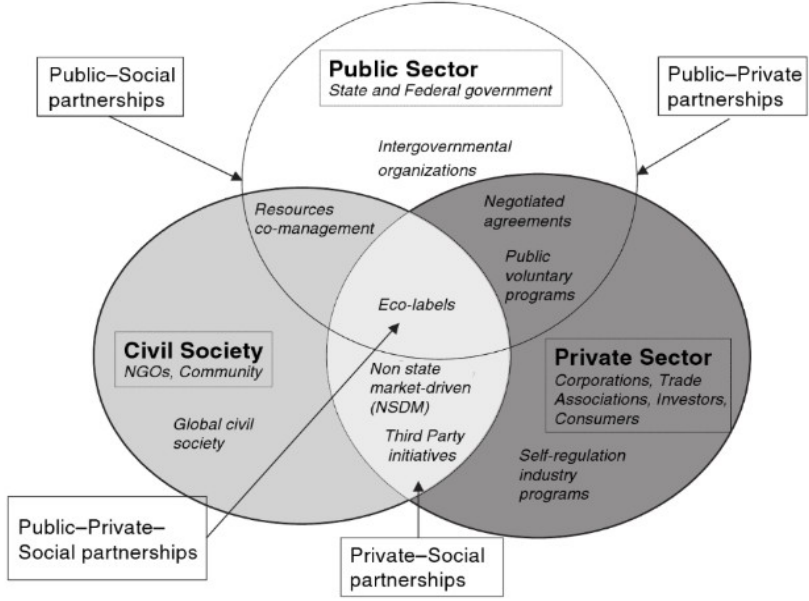
Figure 1. Overlapping public, private and social governance systems (Source: Delmas and Young p.8 [27]).